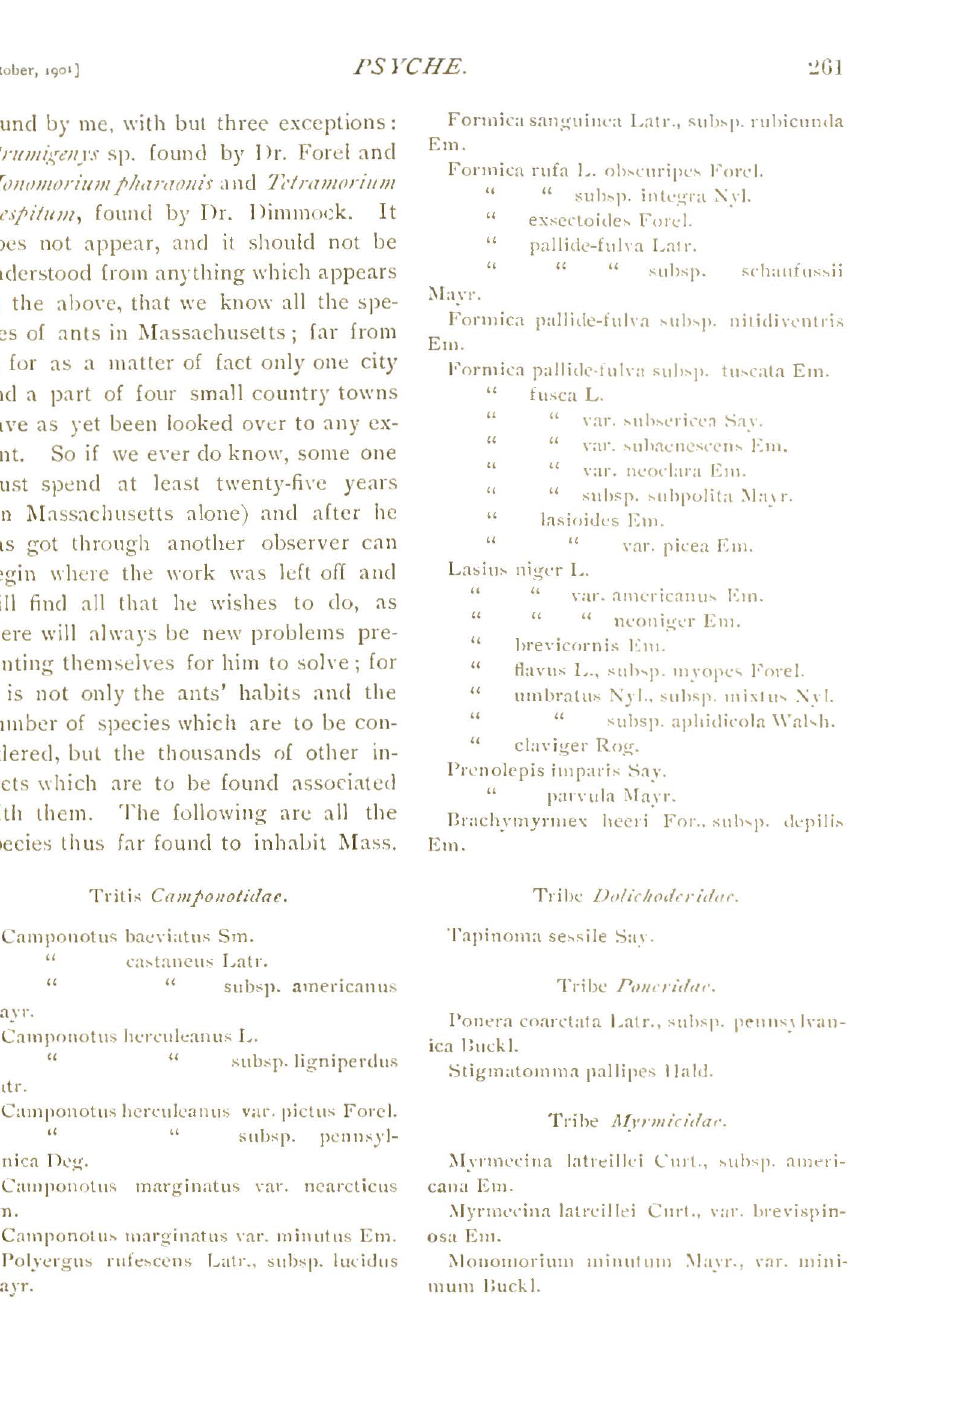
Stigm:.tommn pallipes